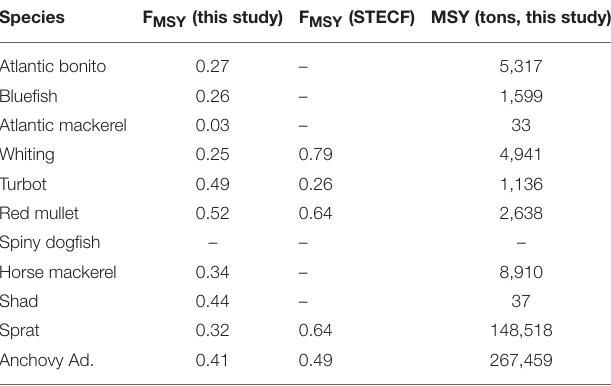
TABLE 2 | Model predictions of fishing mortality (F MSY ) and maximum sustainable yield (MSY) for sustainable fisheries exploitation of fish groups in the Black Sea and their comparison to the F MSY values reported in STECF-15-16